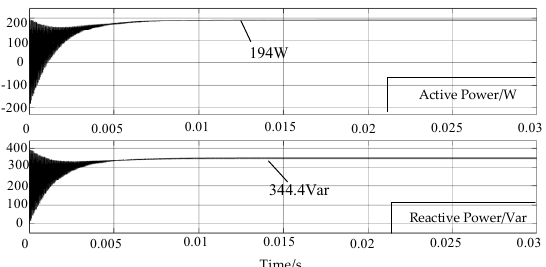
Figure 15. ϕ AD = 30 ◦ and ϕ AB = 163.1 ◦ active power and reactive power waveforms.